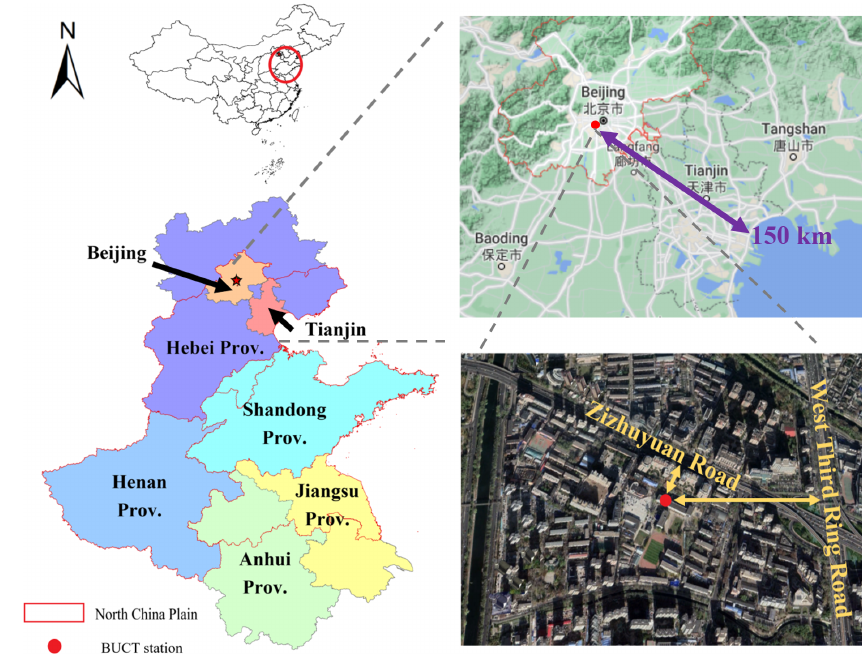
Figure 1. The location of BUCT measurement station. The terrain and satellite maps were revised from © Google Maps. Table 1. Gas-phase acidities and deprotonated anion of a few compounds of interest. Compounds Formula − (cid:49)G ∗ (kJmol − 1 ) Deprotonated anion Hydrobromic acid HBr 1319 Br − Nitric acid HNO 3 1329 NO − Hydrochloric acid HCl 1354 Cl − Nitrous acid HONO 1396 NO − Isocyanic acid HCNO 1415 CNO − Hydrocyanic acid HCN 1433 CN − Hydroperoxy radical HO 2 1450 O − Hypobromous acid HOBr 1460 BrO − Hypochlorous acid HOCl 1461 ClO